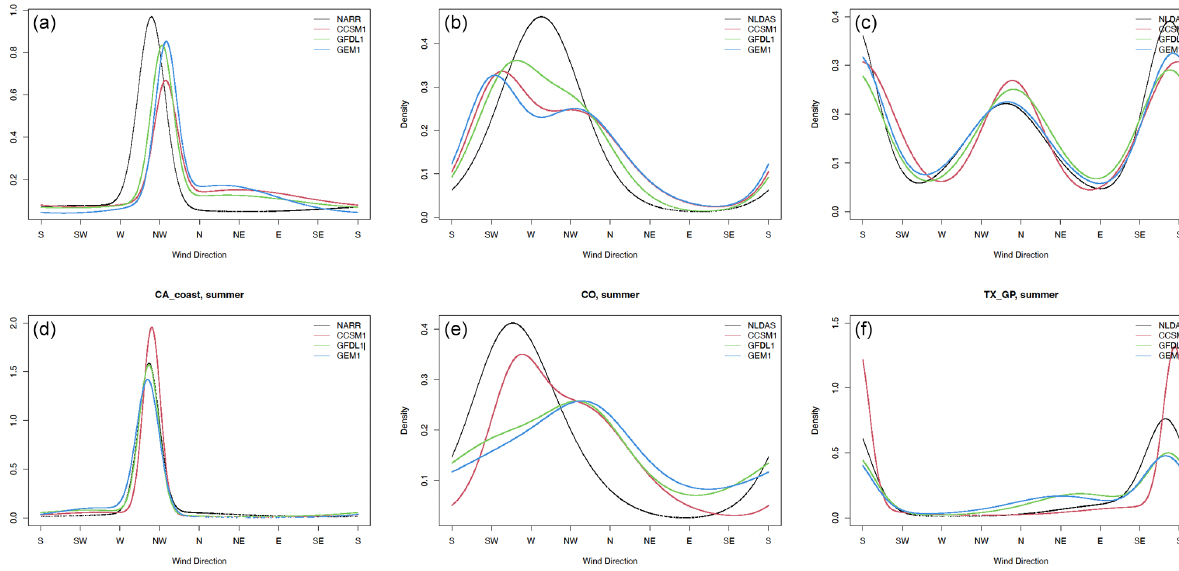
Figure 5. Fitted von Mises mixture densities for historical data. From left to right is offshore California, Colorado, and Texas-SGP. From top to bottom is winter and summer. The black, red, green, and blue curves represent the benchmark (NARR for offshore and NLDAS for inland), WRF-CCSM, WRF-GFDL, and WRF-HadGEM